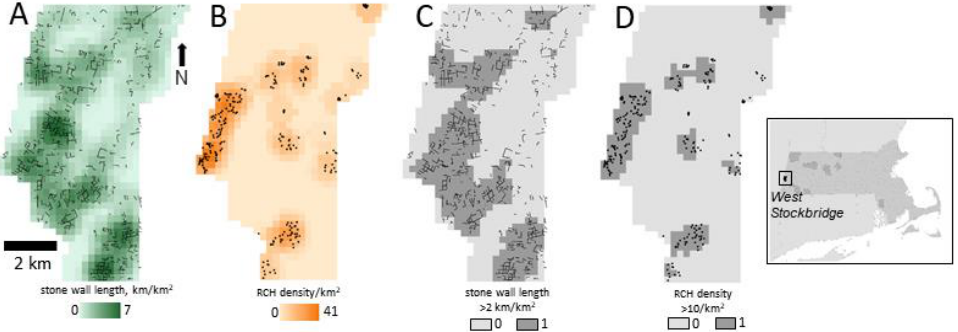
Figure 5. Example showing stone wall ( A ) and relict charcoal hearth (RCH) ( B ) density in West Stockbridge, Massachusetts, and reclassified areas where stone wall length exceeds 2 km/km 2 ( C ) and RCH density exceeds 10/km 2 ( D ). Map projection is NAD 1983 UTM Zone 18N. Table 2. Maximum density values for stone walls and relict charcoal hearths (RCHs) in study towns.